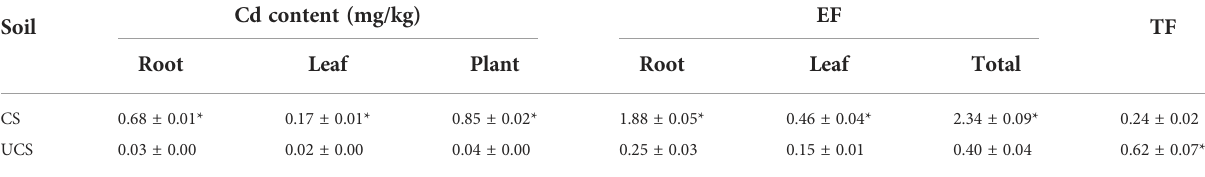
TABLE 2 Cd contents in Zhe-Maidong with different soil.